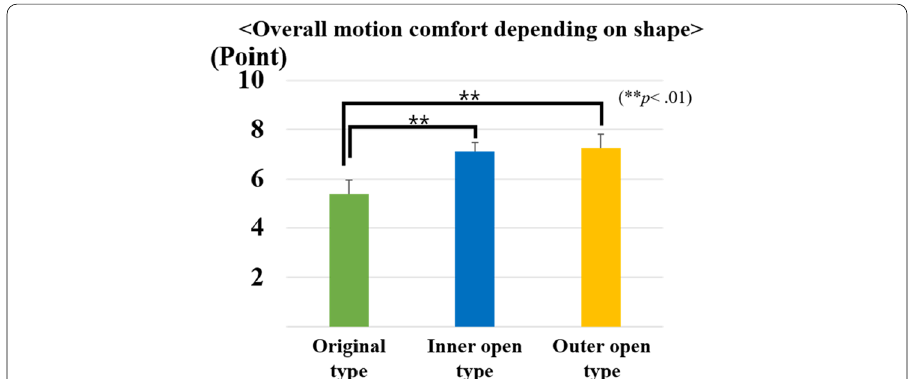
Fig. 12 Subjective motion comfort depending on shape while snowboarding (Bonferroni post hoc analysis method)